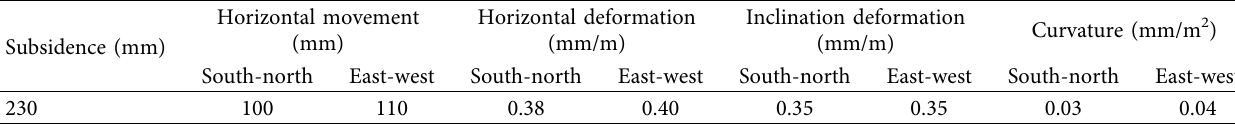
Figure 14: Contour map of surface subsidence in strip mining. Table 3: Surface movement and deformation extremum in strip